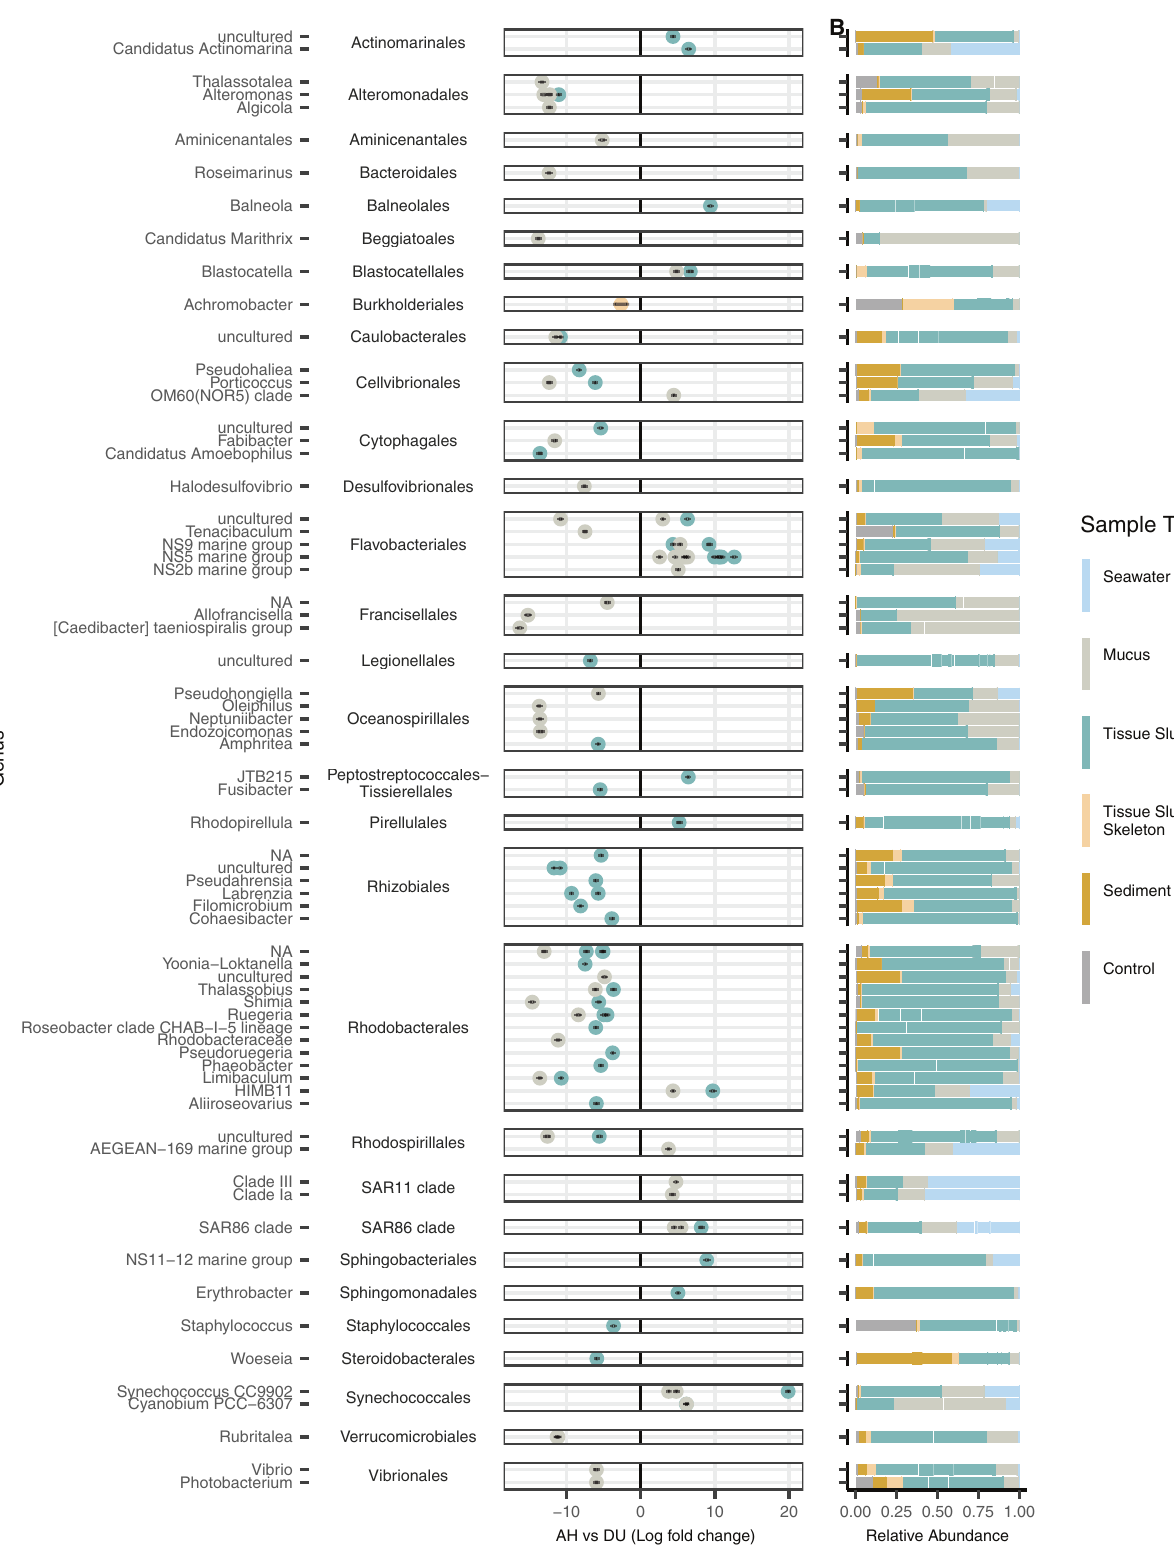
Fig. 5 Microbial amplicon sequence variants (ASVs) associated with unaffected areas on diseased colonies (DU). Differential abundances between ( A ) apparently healthy (AH) vs DU. The y axis depicts ASVs grouped by genus and then by order. Only ASVs with a P adj < 0.001, W statistic >90, and a log-fold change < − 1.5 and >1.5 were visualized. Coral compartments (i.e., mucus, tissue slurry, and tissue slurry skeleton) were included and Acropora spp. were excluded from this analysis. B The relative abundance of taxa enriched in AH and DU by sample type, which includes laboratory controls ( “ Control ” ) encompassing fi eld, lab, kit, and mock